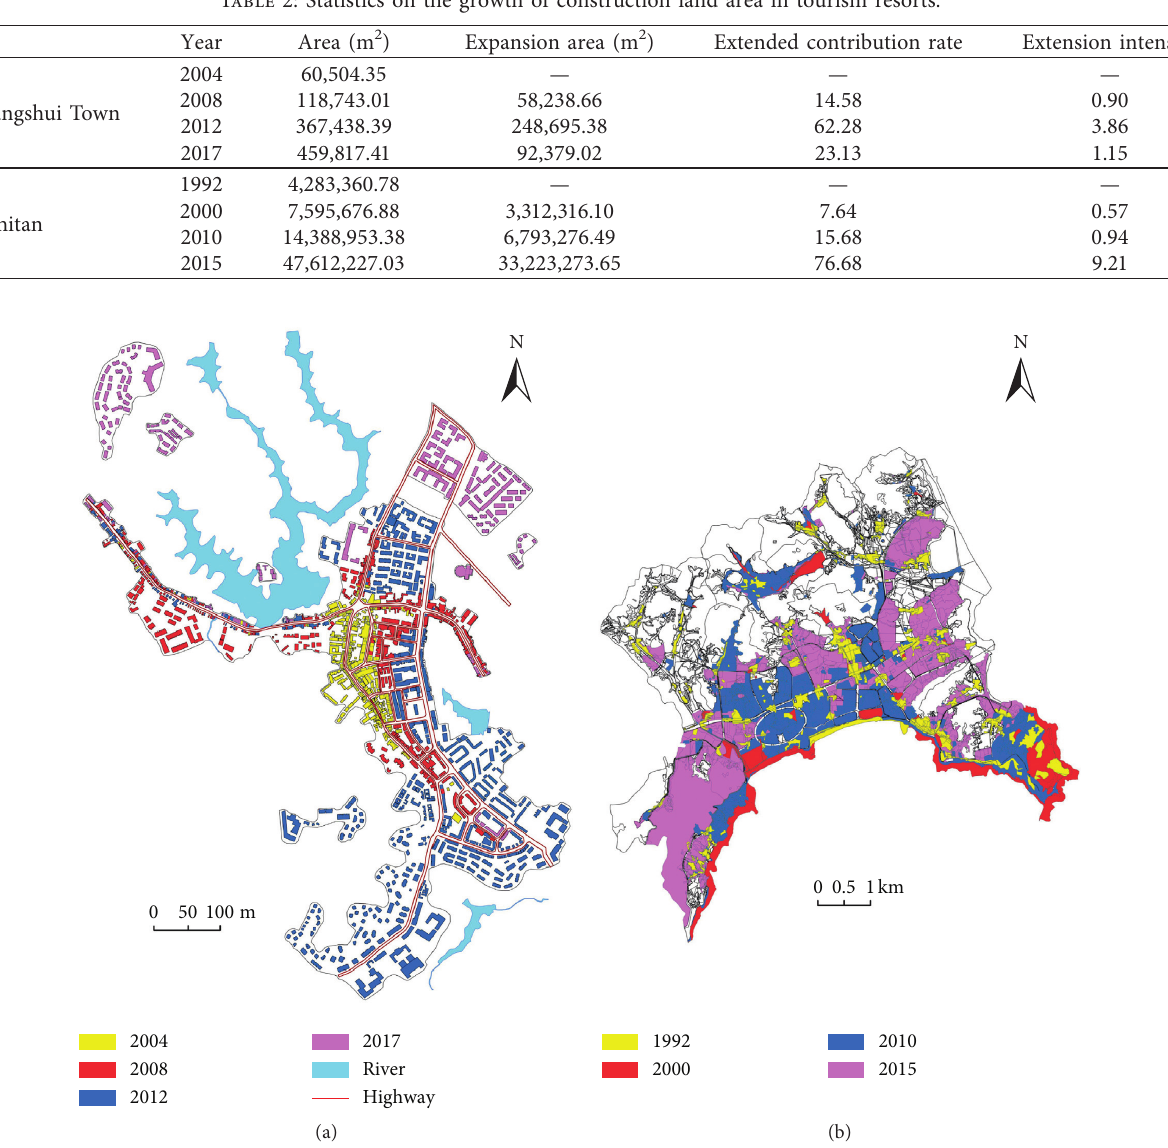
Figure 2: The growth stage of construction land in tourist areas.